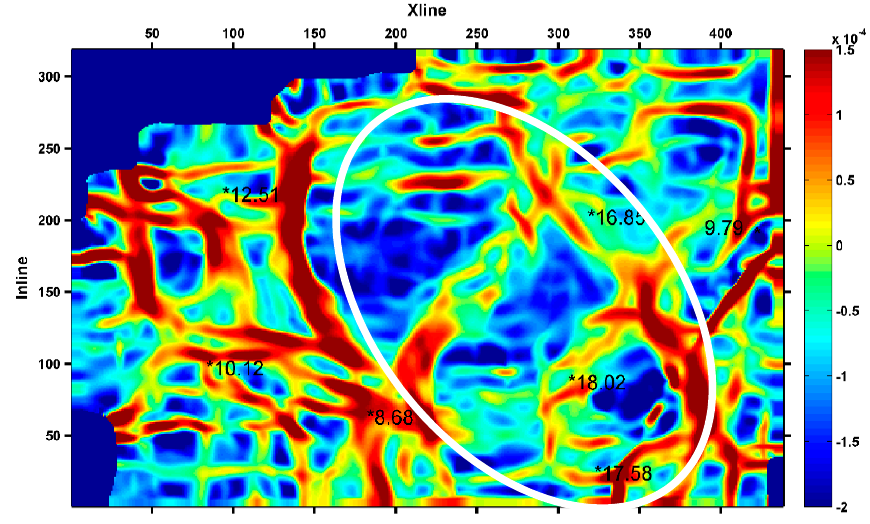
Figure 17. Most positive curvature of 3# coal seam.